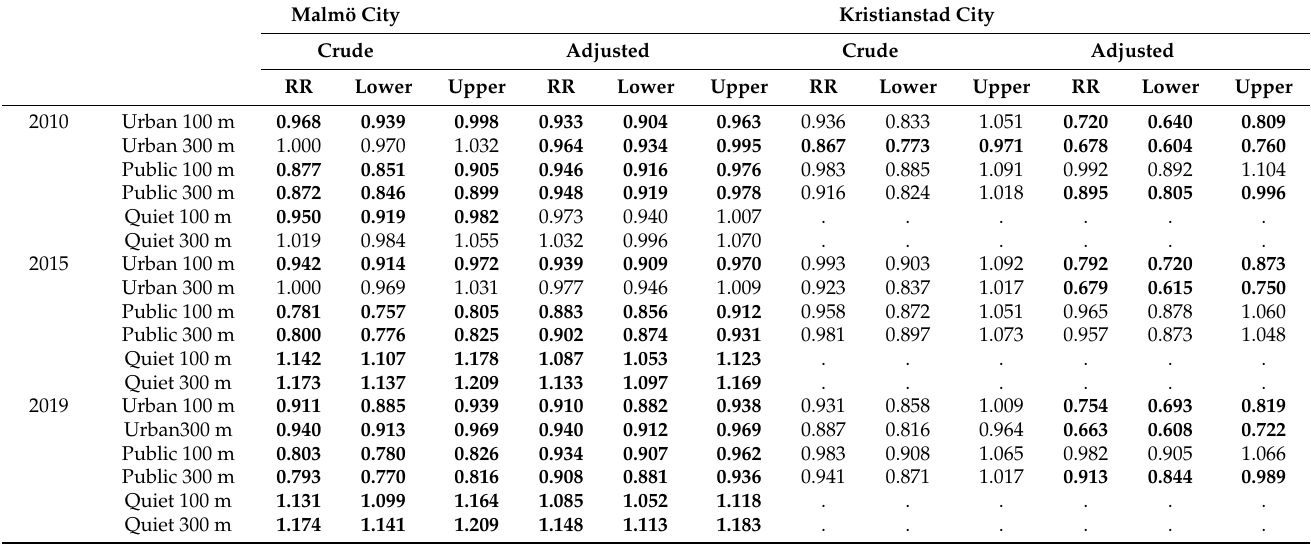
Table A5. Risk ratios for crude and multivariate associations between born in Sweden vs born abroad in availability to total urban green space (Urban), publicly available urban green space (Public) and quiet publicly available urban green space (Quiet). RR for 100 m and 300 m buffer distances from the residence for the three different types of urban green spaces are presented. Malmö City Kristianstad City Crude Crude